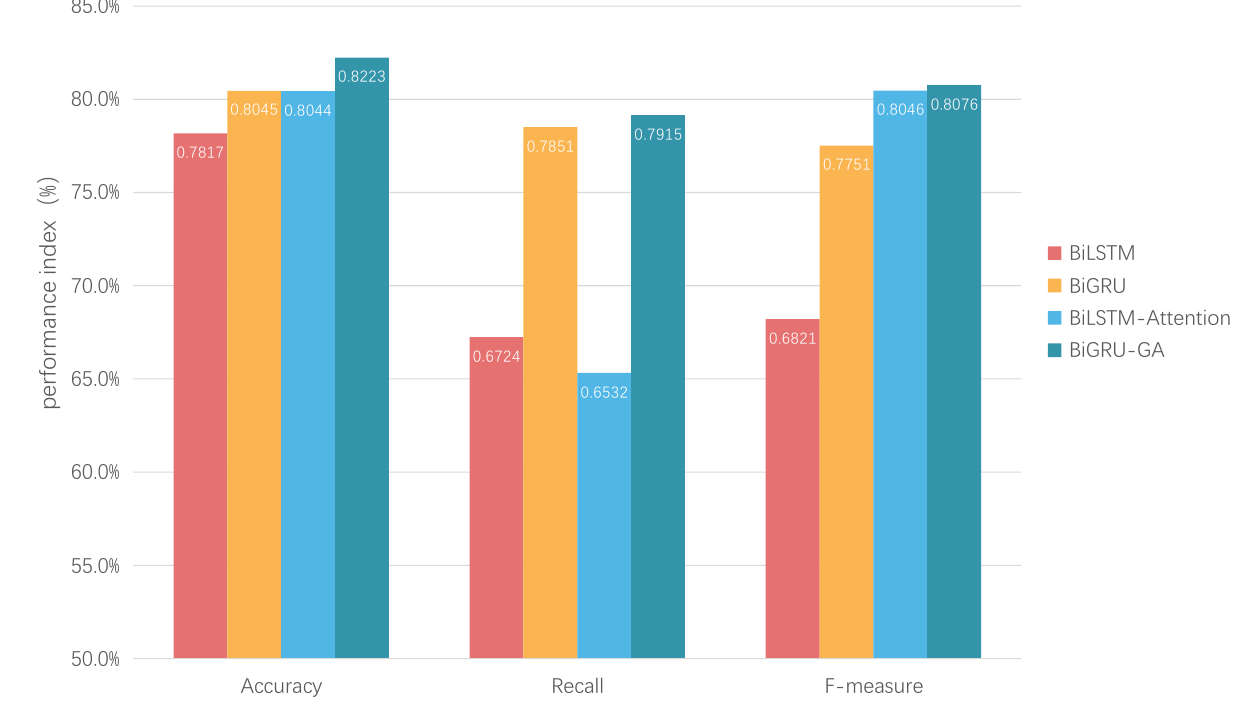
Figure 17. Experimental relation extraction results of model performance comparison.